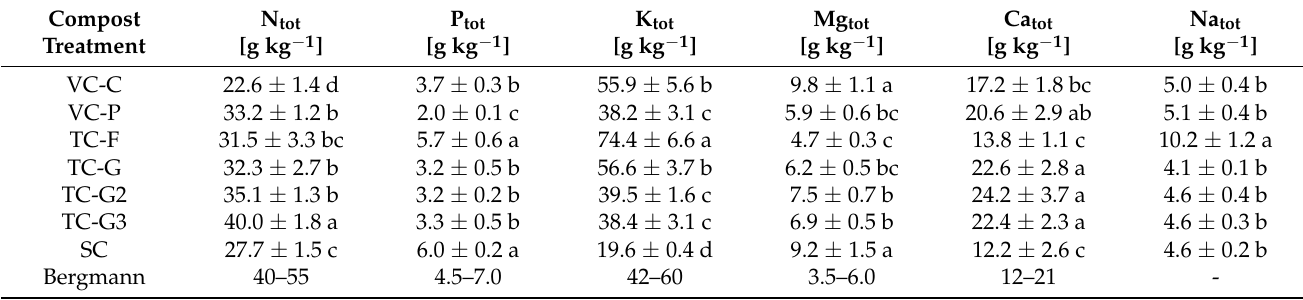
Table A2. Nutrient content in the lettuce shoots for the different treatments and optimum nutrient levels for lettuce leaves, according to Bergmann [56]. Treatments: VC-C (coir + kitchen waste vermicompost), VC-P (paperboard + kitchen waste vermicompost), TC-F (fecal compost), TC-G (green waste compost), TC-G2 and TC-G3 (green waste compost with additional N fertilization), SC (sand control).